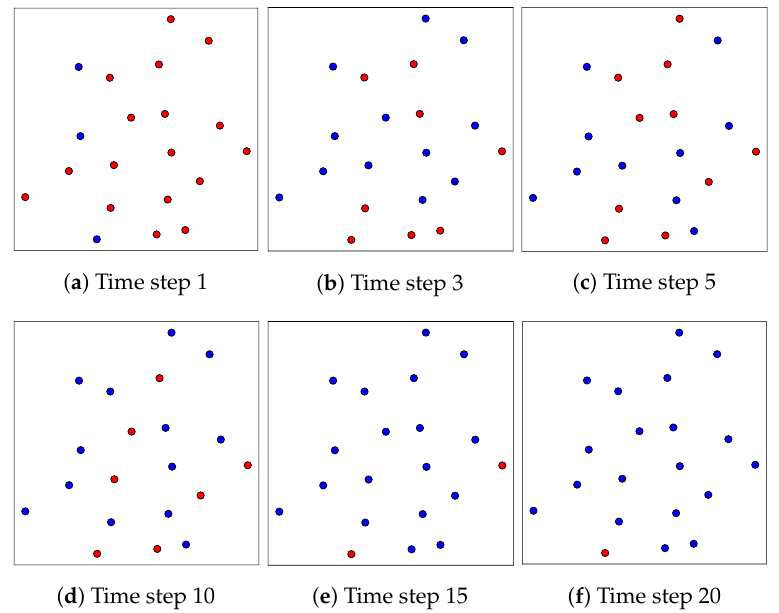
Figure 5. Snapshots of different time steps of a leader selection simulation. Blue dots represent robots whose LED is deactivated and red balls indicate that the agent’s LED is turned on. Figures ( a – e ) correspond to negotiation phase while in ( f ) the leader is selected and stabilized. Remark: the simulation trial is not the same as the one exposed in Figure